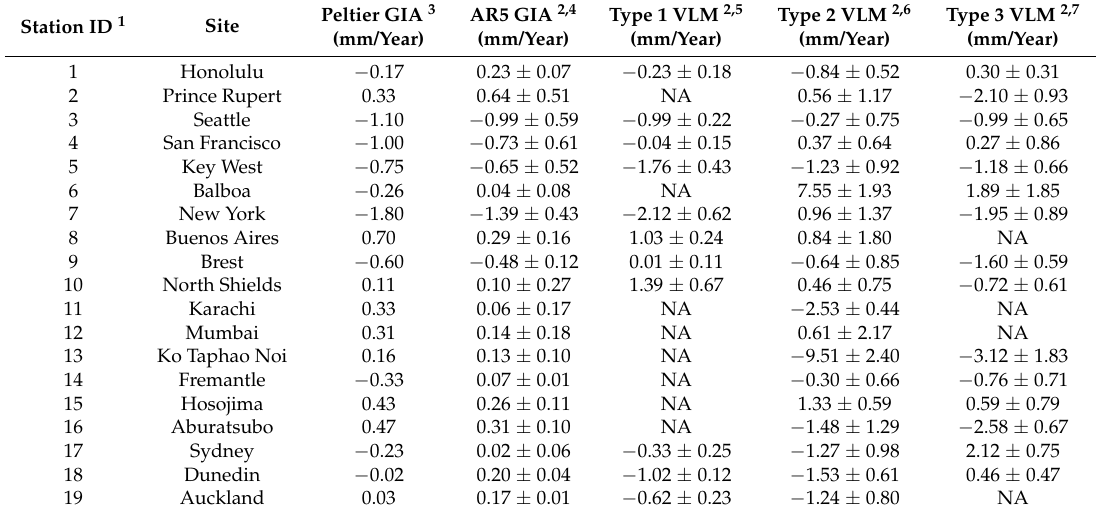
1 Refer to Figure 1 and Table 1 for further details. 2 Error margins advised are standard errors (i.e., 1 σ ). 3 Peltier GIA estimates [33] at tide-gauge sites available from PSMSL [12]. Aligned with VLM prediction for